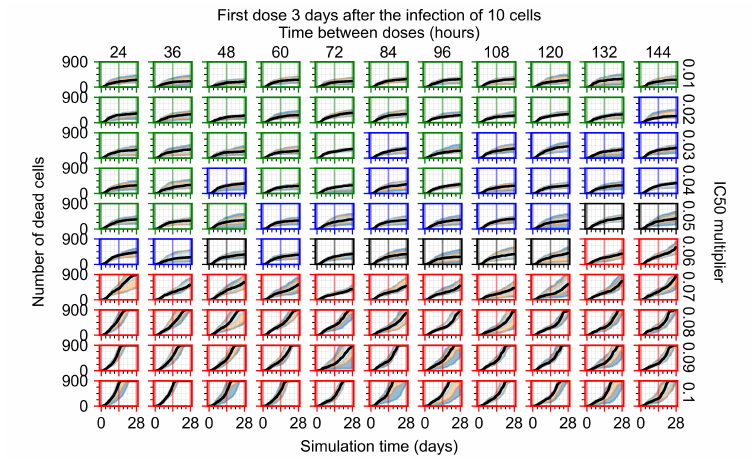
Figure A33. Dead population.